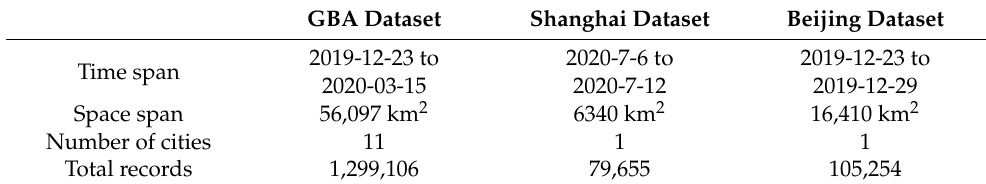
Table 1. Detailed information of the three datasets, showing the different spatio-temporal scales.